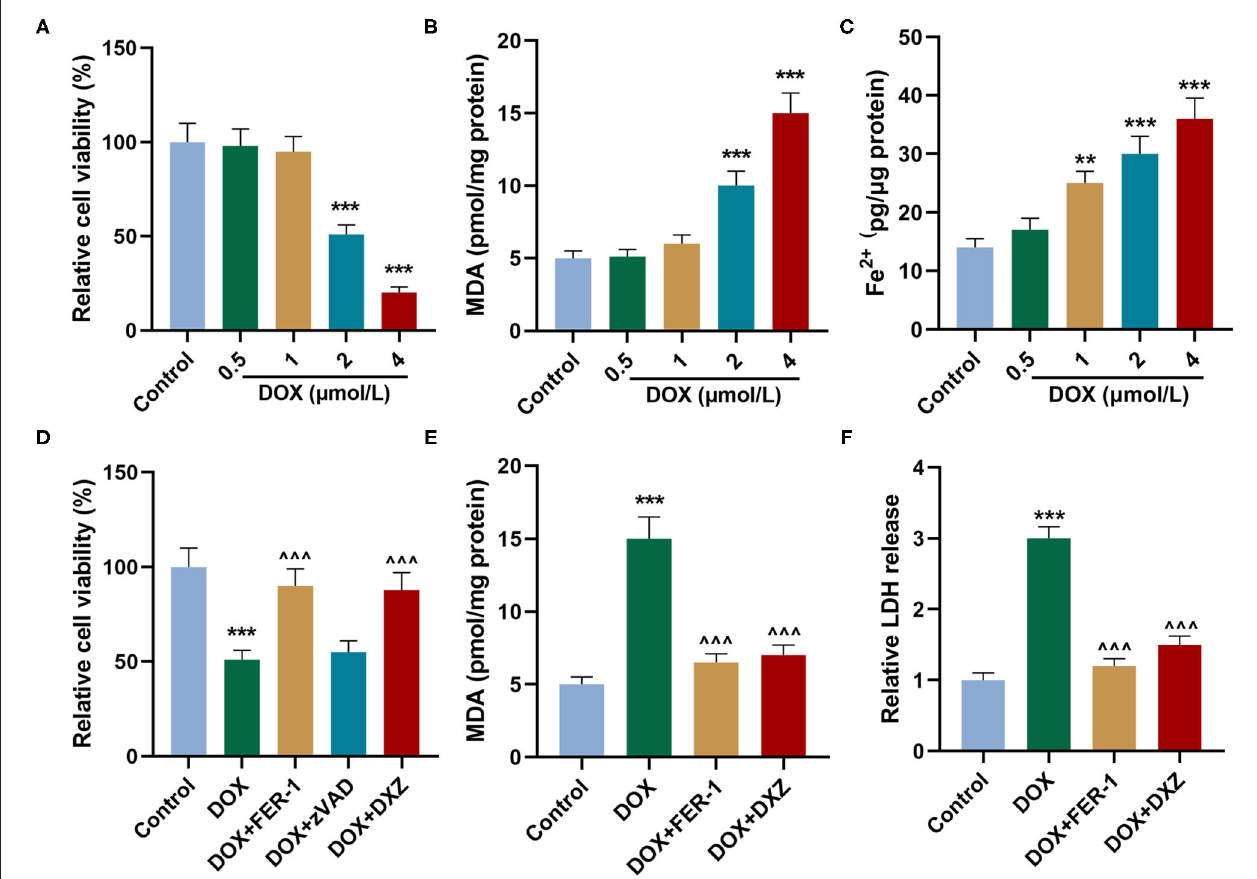
FIGURE 6 | Effects of HMGB1 and DXZ on DOX-treated injury of H9c2 rat cardiomyocytes. (A) The viability of H9c2 cells after the incubation of DOX for 12h at 0 (control), 0.5, 1, 2, and 4 µ mol/L was detected by MTT assay. (B) The levels of MDA in H9c2 cells after the incubation of DOX for 12h at 0 (control), 0.5, 1, 2, and 4 µ mol/L were detected by a commercial kit. (C) The Fe 2 + content of H9c2 cells after the incubation of DOX for 12h at 0 (control), 0.5, 1, 2, and 4 µ mol/L was detected by assay kits. (D) The viability of H9c2 cells after drug treatment in the control group or DOX-treated cells after incubation of FER-1 (10 µ mol/L), zVAD (20 µ mol/L, an apoptosis inhibitor), or DXZ (100 µ mol/L) for 72h was detected by MTT assay. (E) The MDA levels in H9c2 cells after drug treatment for 24h were detected by a commercial kit. (F) The LDH levels in H9c2 cells after drug treatment for 24h were detected by a commercial kit. ** P < 0.01, *** P < 0.001 vs. control. ∧∧∧ P < 0.001 vs. DOX. Each experiment was repeated three